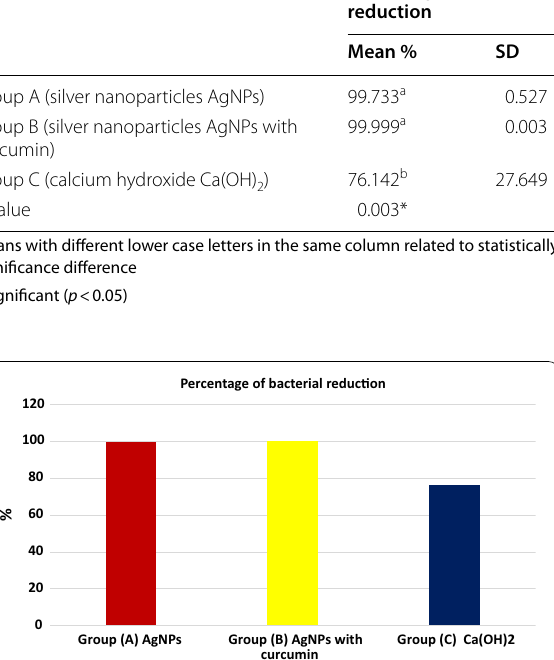
Table 2 Standard deviation (SD) values, the mean of percentage of bacterial reduction of tested groups